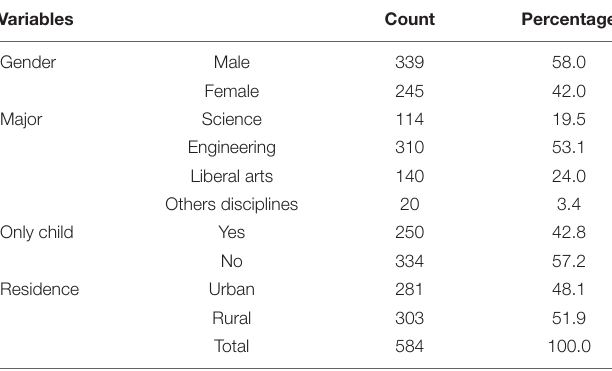
TABLE 1 | Distribution of the respondents by demographic characteristics ( N =